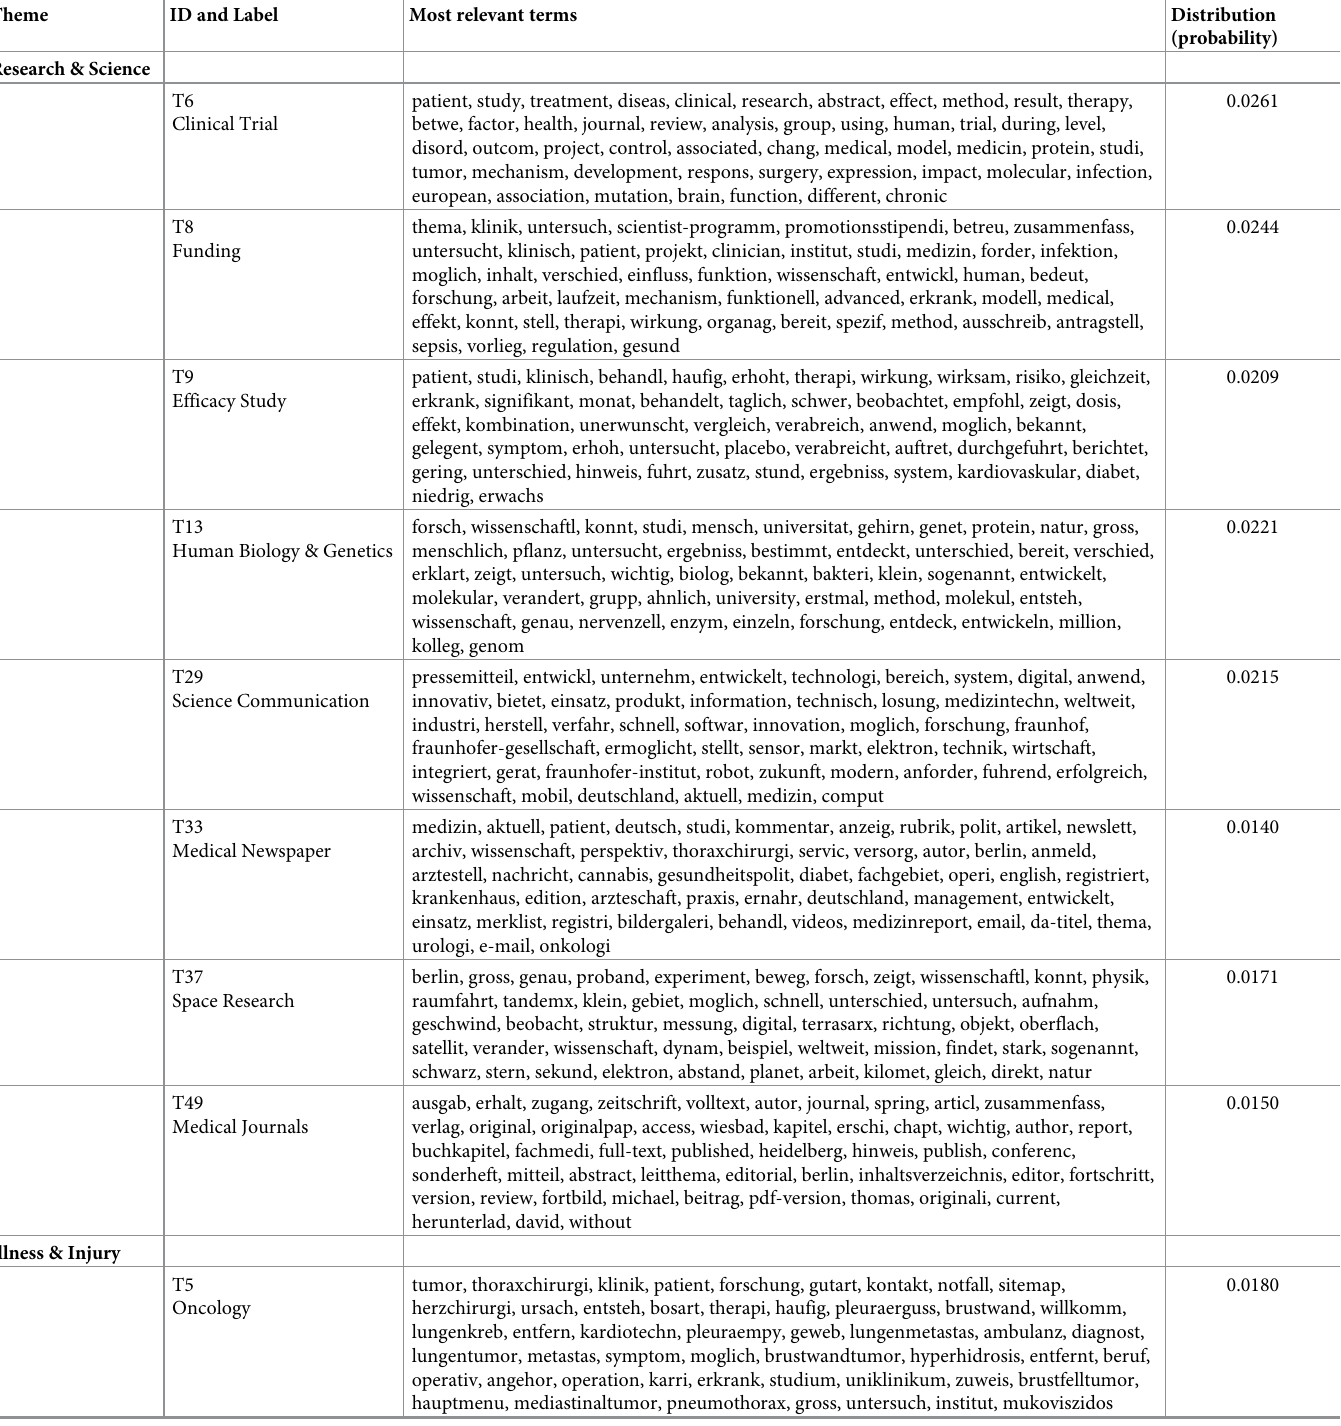
Table 5. The 50 topics that were identified from the web pages of the top 1000 web sites for each ccTLD. The sample terms were ordered based on their relevance to the topic.